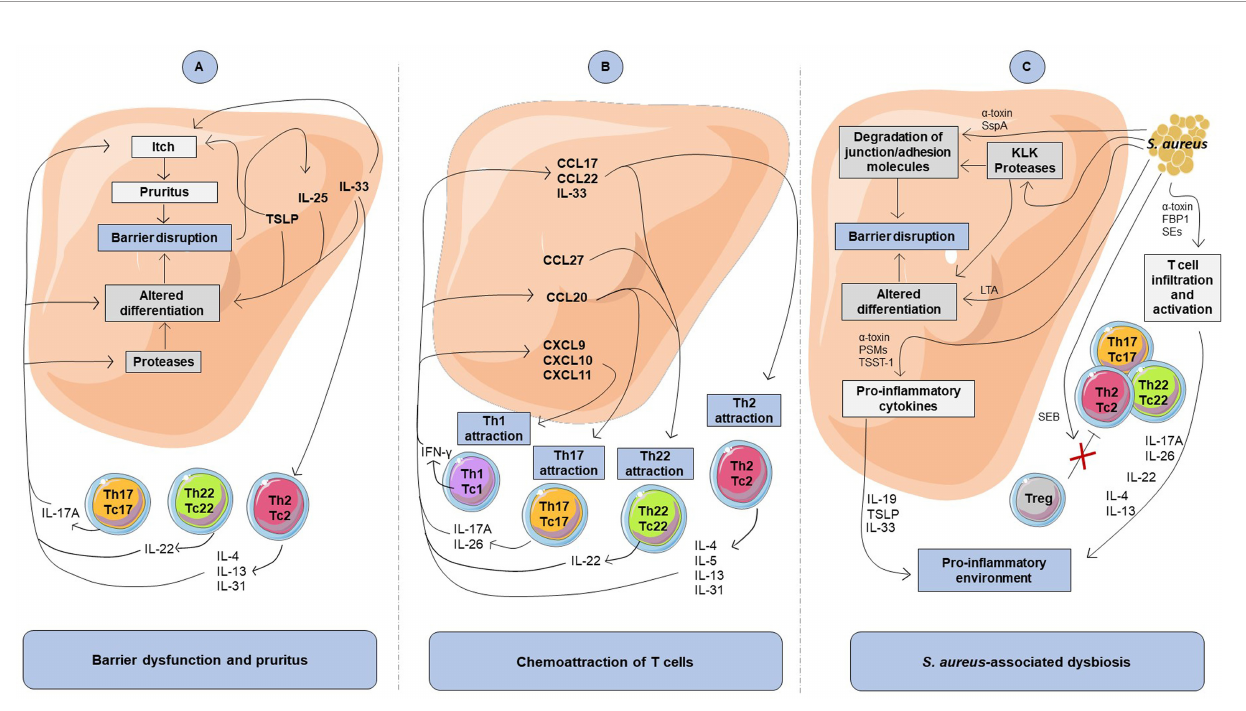
FIGURE 1 | Impact of cytokine-mediated crosstalk between keratinocytes and T cells on atopic dermatitis features. (A) Involvement of the cytokine-mediated crosstalk in barrier dysfunction and pruritus. Th2, Th17, and Th22 cytokines inhibit differentiation markers and favor itch, leading to barrier disruption, which in return induces secretion of pro-in fl ammatory cytokine including TSLP, IL-33, and IL-25 by keratinocytes. (B) Involvement of the cytokine-mediated crosstalk in chemoattraction of T cells. The keratinocyte-derived in fl ammatory mediators include chemokines that lead to chemoattraction of T cells. Attraction of T cells and Th2 response promote a pro-in fl ammatory cytokine production loop in keratinocytes. (C) Impact of S. aureus on keratinocytes and T cells in atopic dermatitis. Virulence factors produced by S. aureus can promote degradation of junctional adhesion molecules and alteration of keratinocyte differentiation that contribute to atopic skin barrier disruption. S. aureus can also favor a pro-in fl ammatory environment through Th2 cell in fi ltration into the skin, pro-in fl ammatory cytokine release by keratinocytes and T cells as well as by inhibiting Treg immunosuppressive activity. FBP1, fi bronectin-binding protein-1; LTA, lipoteichoic acid; PSMs, phenol soluble modulins; SEs, staphylococcal enterotoxins; SspA, serine protease A; TSST-1, toxic shock syndrome